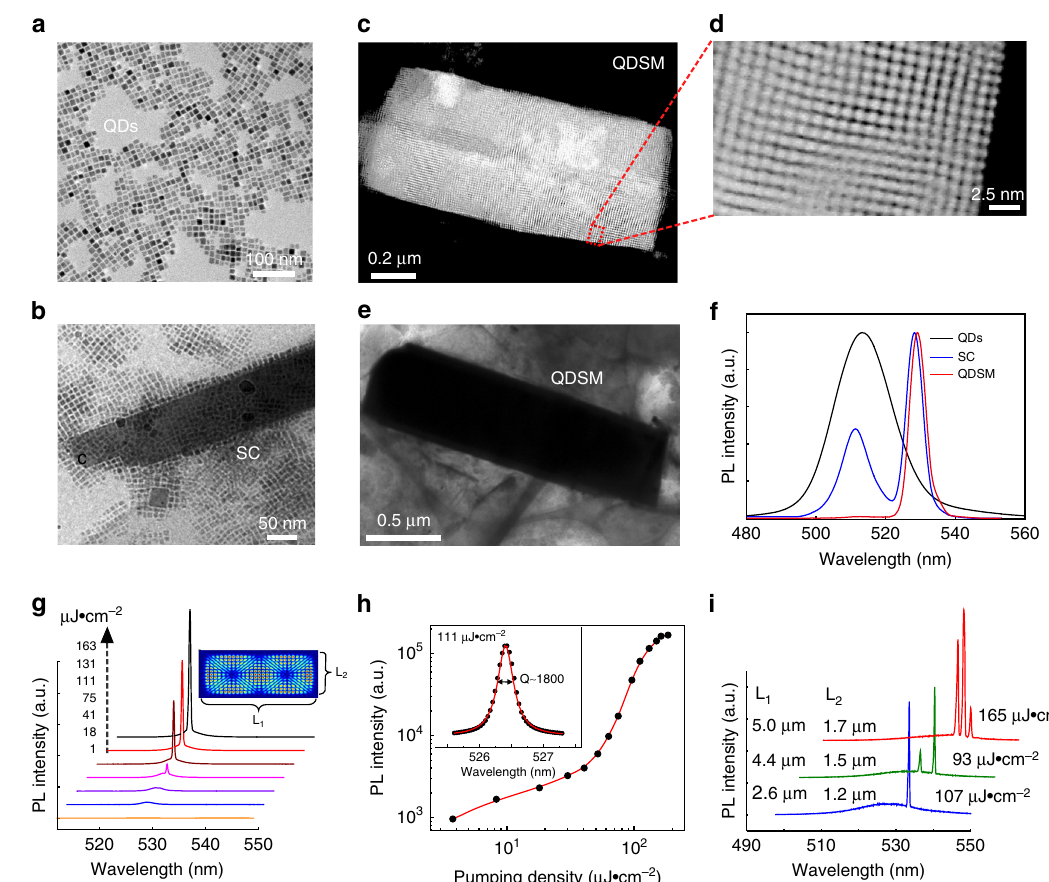
Fig. 2 Dynamic tracing and optical characterization of perovskite QDSMs. a TEM image of monodisperse CsPbBr 3 cubic QDs. b – e TEM images of the evolution of monodisperse QDs ( a ) self-assembling into closely packed SC ( b ) and fi nally to the rectangular QDSM ( e ) via low-temperature aging and drying-mediated methods. Rows of dots capped with oleylamine and oleic acid arrange themselves along the crystalline axis ( b ) and fi nally form sharp edges and regular shape ( e ). c is the annular TEM images of the cuboid QDSM and d is a close-up view of the red dotted box in c . f PL spectra of different structures. g PL spectra of the cavity-enhanced SF effect from a QDSM at 77 K. Inset: the simulated fi eld distribution of the whispering gallery mode, L 1 and L 2 are long side and short side of the QDSM, respectively. h Power dependence of the PL intensity in cavity mode. Inset: Lorentz fi tting of the cavity mode. i The resonant optical modes of QDSMs with different sizes. Multimode lasing can be obtained and the spacing between two adjacent modes decreases with the increasing of cavity